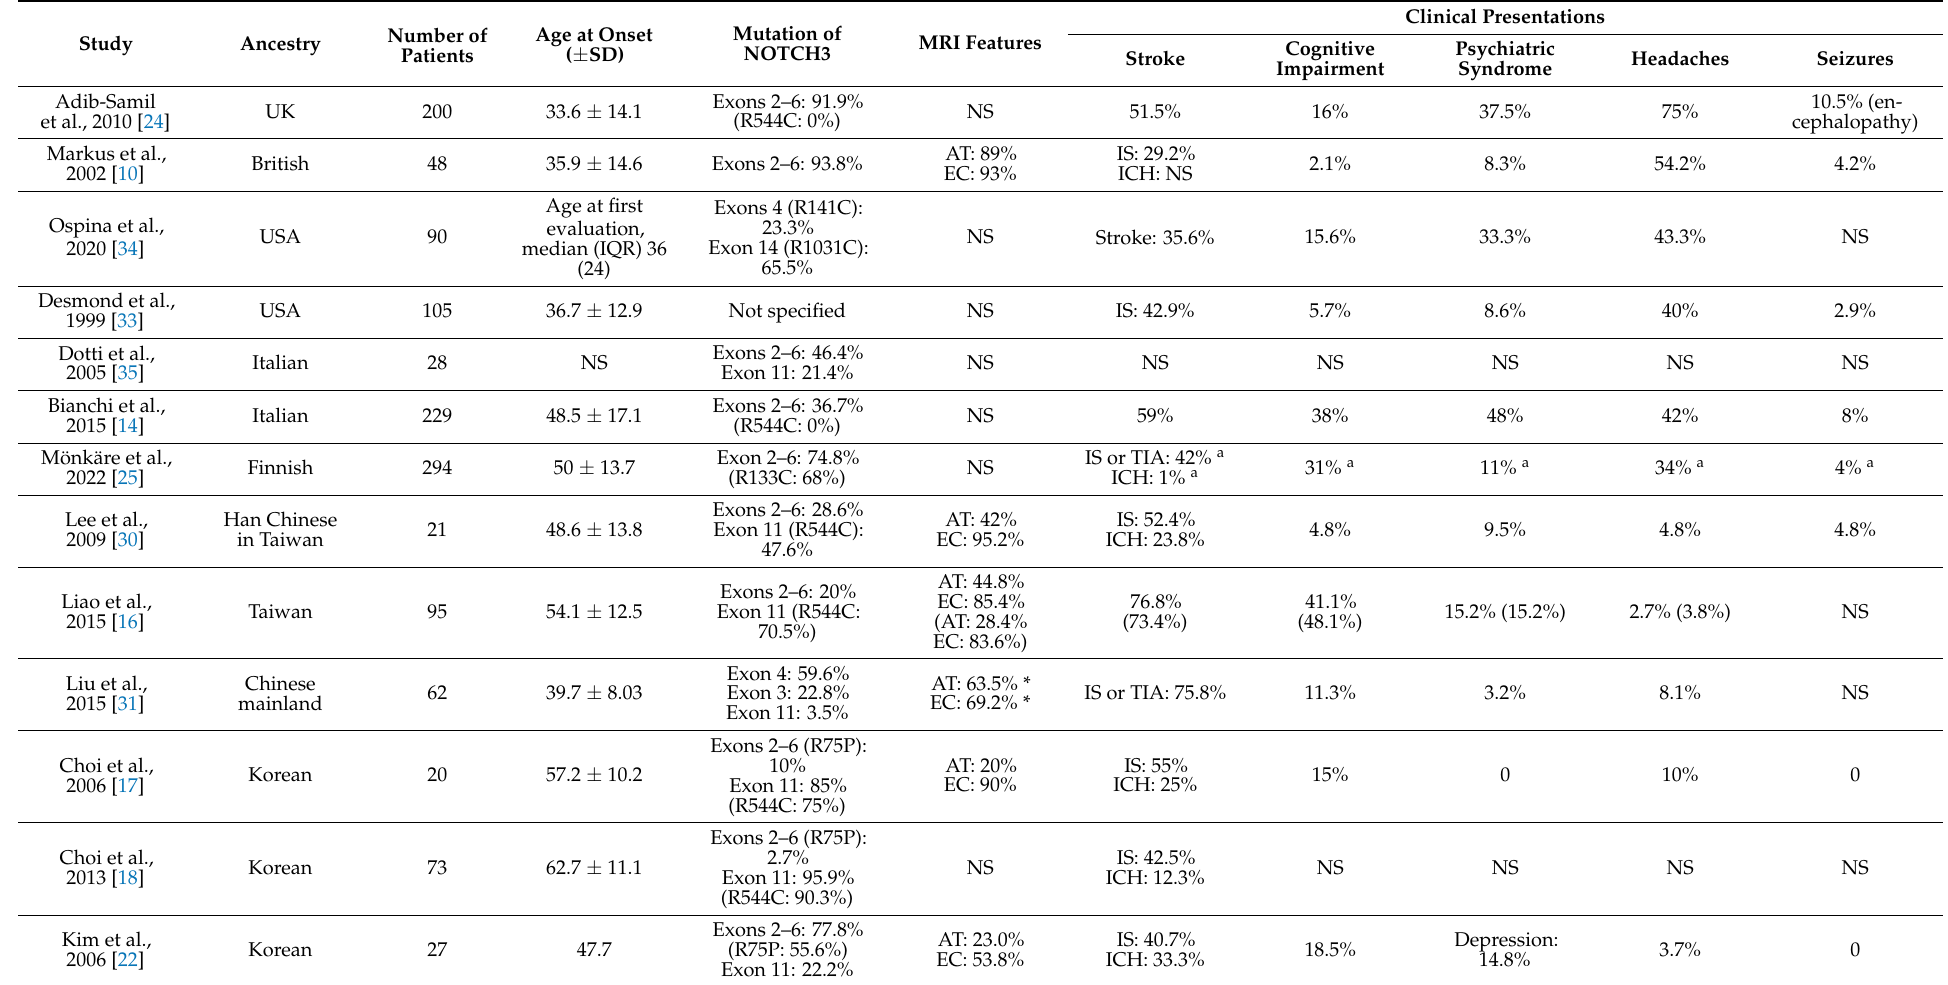
Table 1. Comparison of the different spectrum of NOTCH3, MRI features, and clinical presentations of